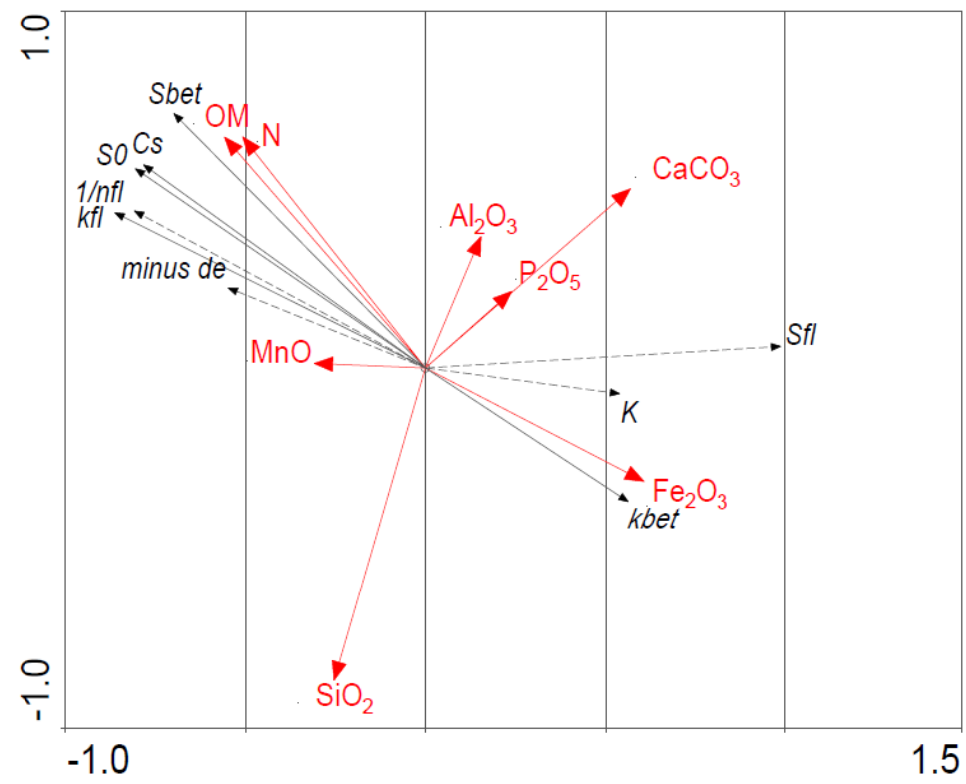
Figure 10. Results of RDA analysis of dependence between P adsorption characteristics (response variables) and chemical composition of bottom sediment (explanatory variables).